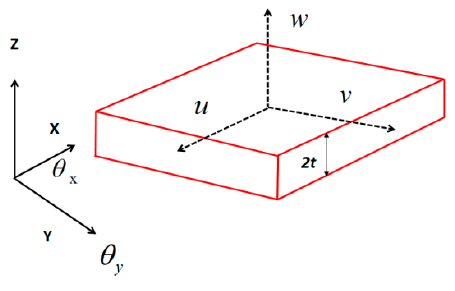
Figure 1. Plate model notion.